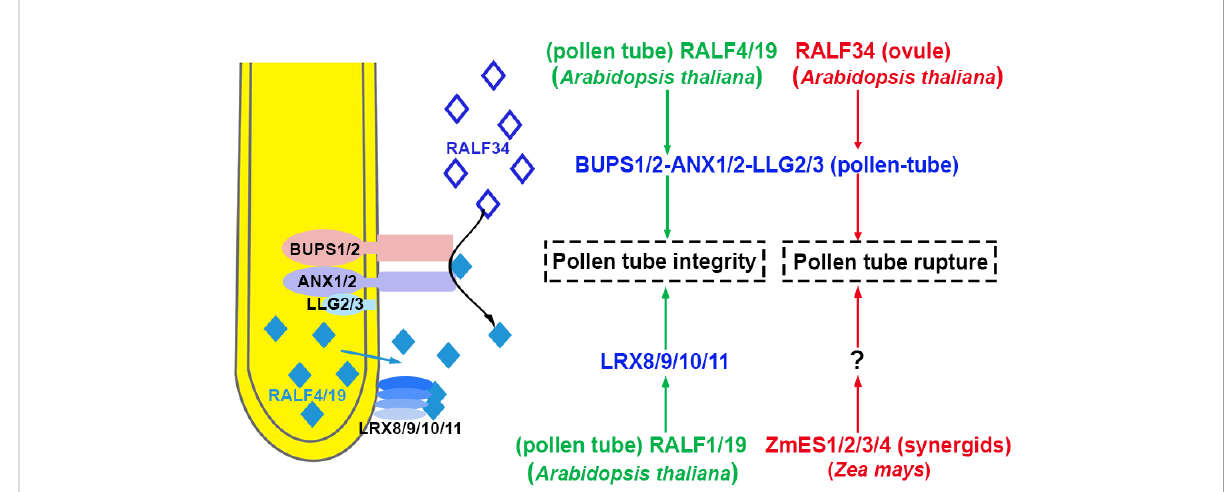
FIGURE 3 The integrity of pollen tube growth is maintained, and pollen tubes rupture In Arabidopsis thaliana , pollen-speci fi c RALF4/19 orchestrates pollen tube receptor complexes BUPS1/2-ANX1/2-LLG2/3 and LRX8/9/10/11 to maintain pollen tube growth and integrity in the transmitting tract. After the pollen tube enters the ovule, the ovule-speci fi c RALF34 interacts with BUPS1/2-ANX1/2-LLG2/3, resulting in pollen tube rupture. In Zea Mays , ZmES1/2/3/4 secreted from synergid cells causes pollen tube rupture. The peptides involved in the activation and inhibition of signaling pathways are highlighted in green and red, respectively. The blue represents receptor complexes and the co-receptors are shown in parentheses. Question marks indicate unidenti fi ed signal components. The source of peptides and receptors is shown in parentheses. Abbreviations for all small peptides and receptors are elucidated in the